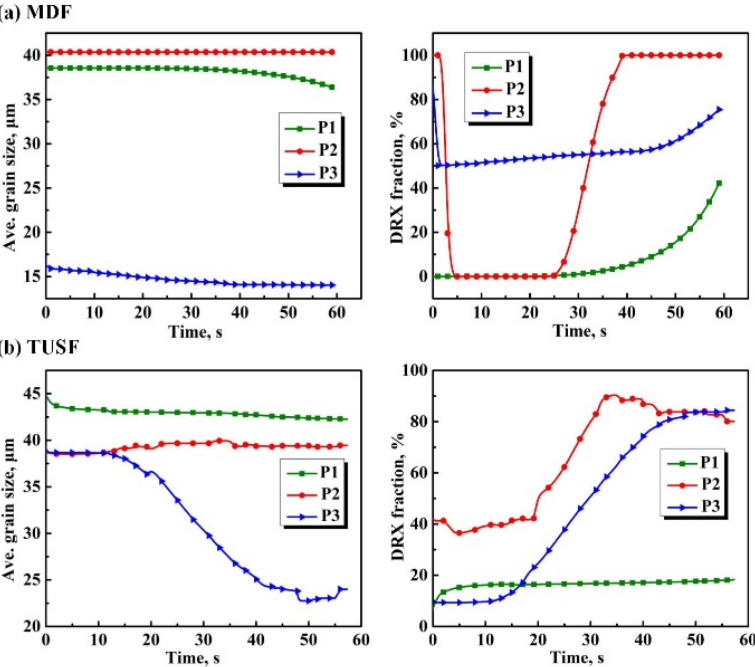
Figure 18. Time-dependent average grain size and DRX fraction curves for ( a ) MDF and ( b ) TUSF specimens at different tracking points.